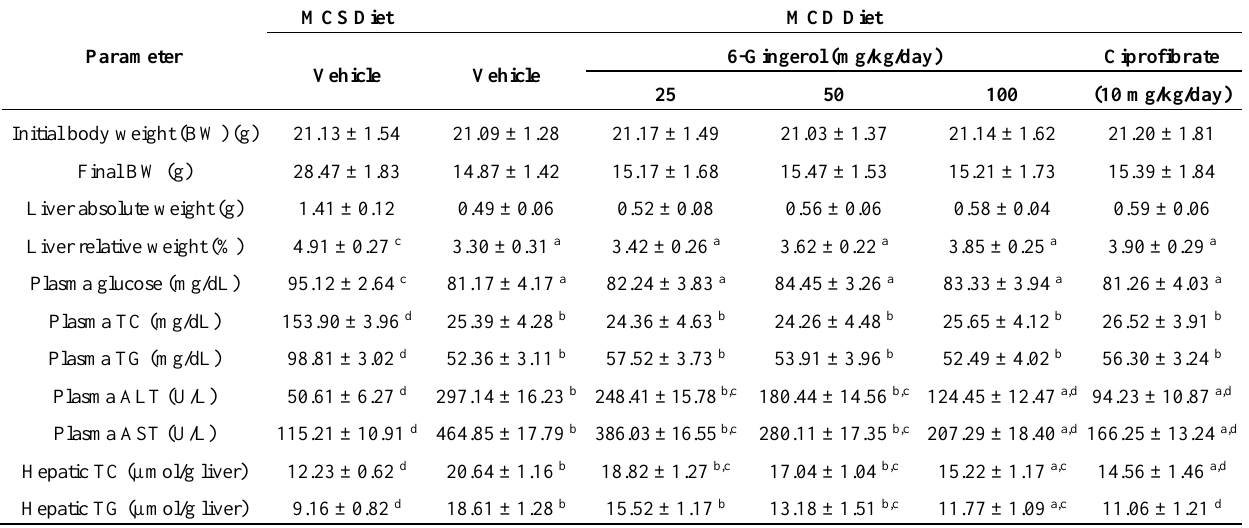
Table 1. Effects of treatments on blood biochemistry and hepatic parameters in MCS-diet- or MCD-diet-fed mice receiving four-weeks of